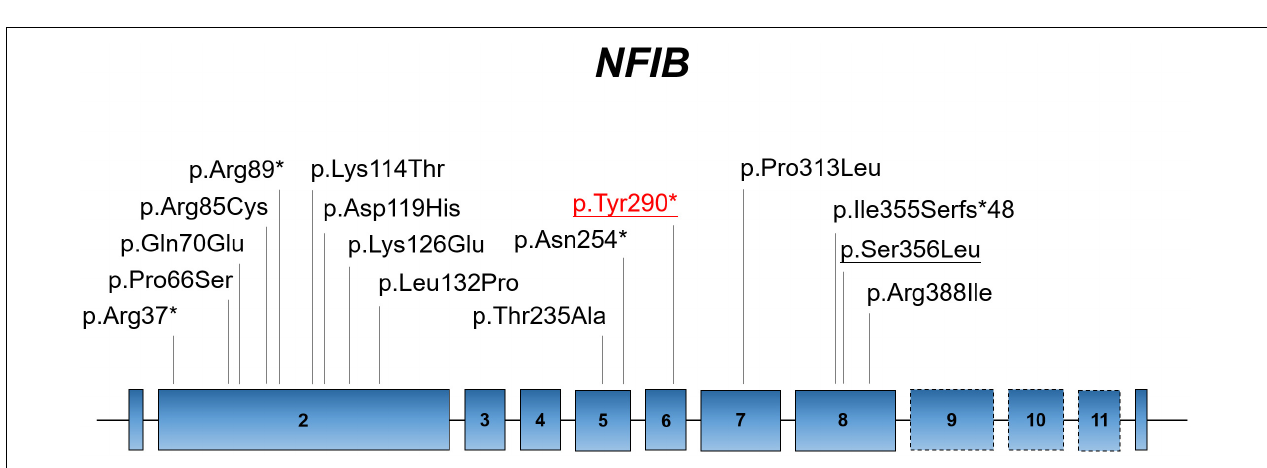
FIGURE 2 | Localization of known mutations on the linear topology of NFIB . Red labeling represents the mutation identified in the present study. Underlined labels symbolize the fetal case.